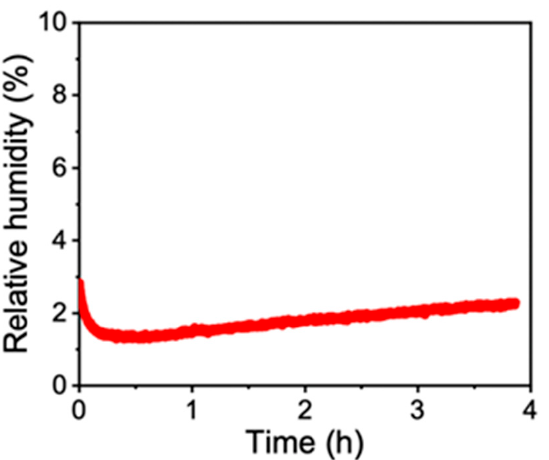
Figure 3. Typical change in the relative humidity in the sealed chamber during thermal diffusivity measurement.